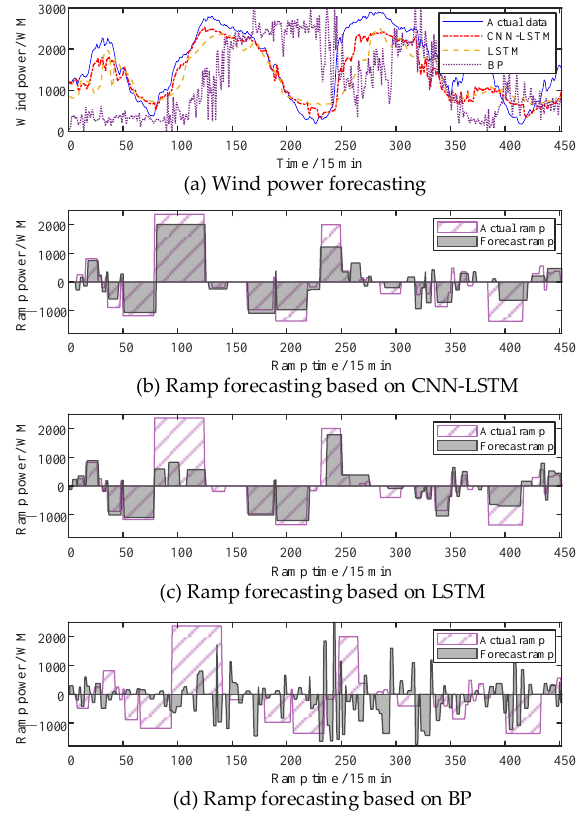
Figure 12. Ramp forecasting results based on CNN–LSTM.